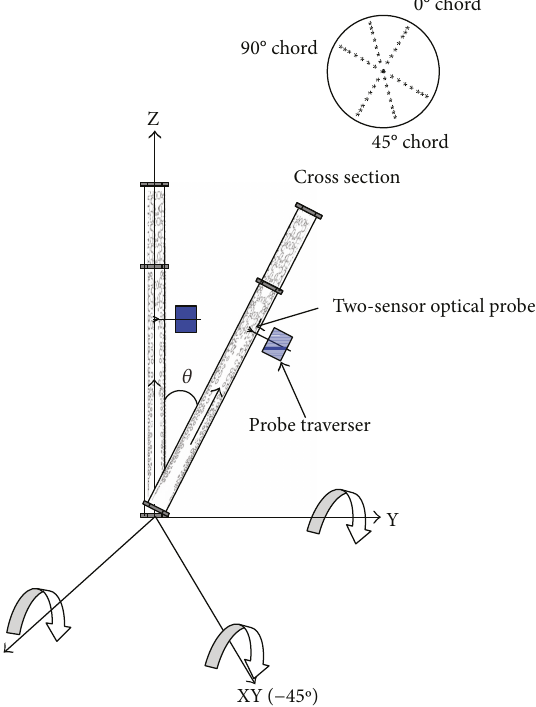
Figure 3: Diagram of test section under vertical and inclined